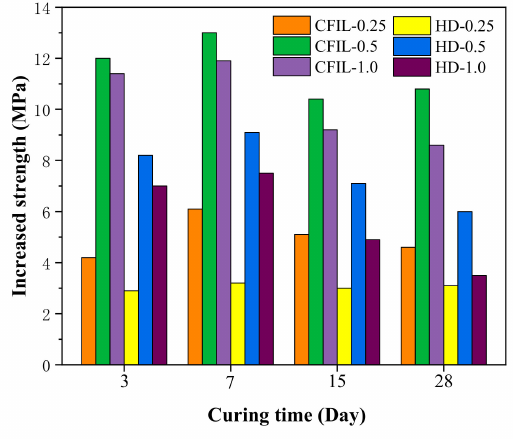
Figure 4. Increase in CS relative to NCH-0 for each ARGF experimental